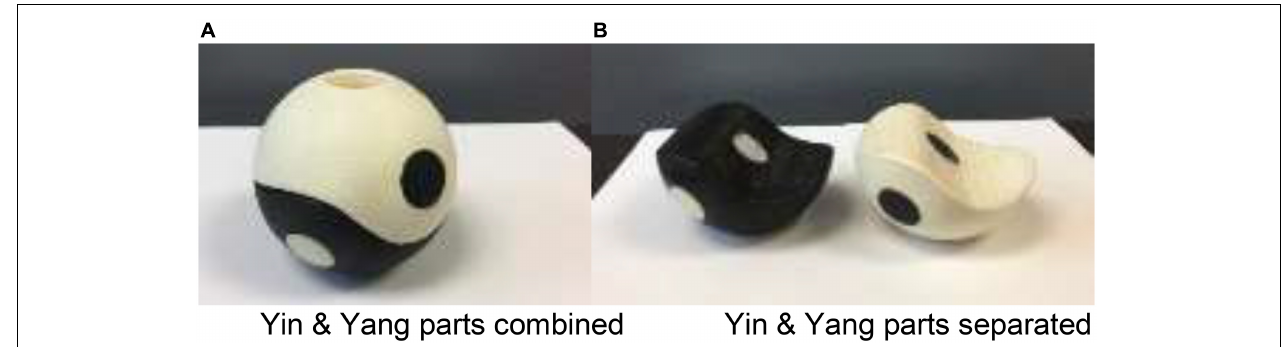
FIGURE 1 | (A) Tai Chi Ball is combined with poly-magnets. (B) Tai Chi Ball is separated by twisting it.